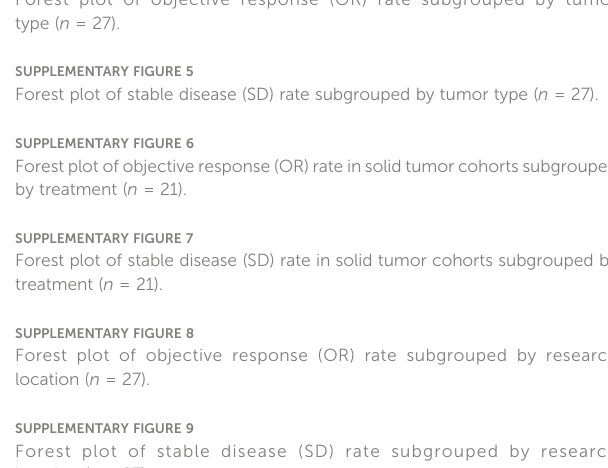
SUPPLEMENTARY FIGURE 3 Forest plot of stable disease (SD) rate subgrouped by treatment strategy ( n = 27). SUPPLEMENTARY FIGURE 4 Forest plot of objective response (OR) rate subgrouped by tumor type ( n = 27).